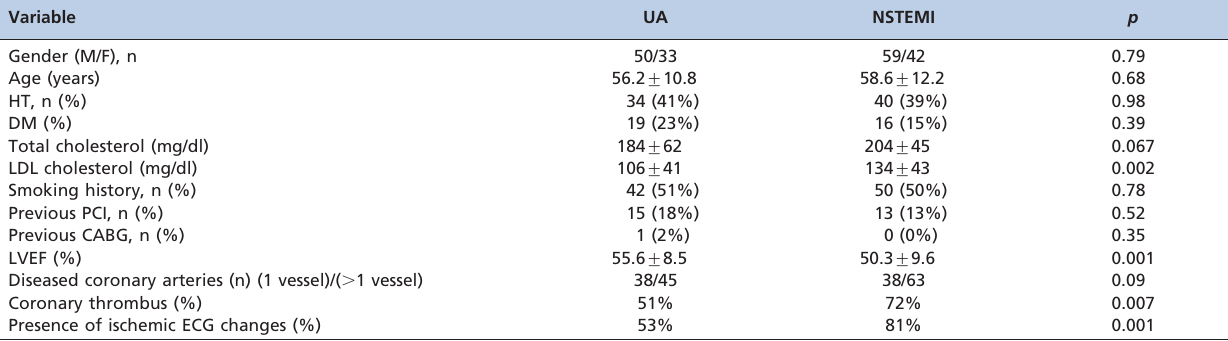
Table 1 - Baseline characteristics of the study population, stratified according to the final diagnosis of the study patients.